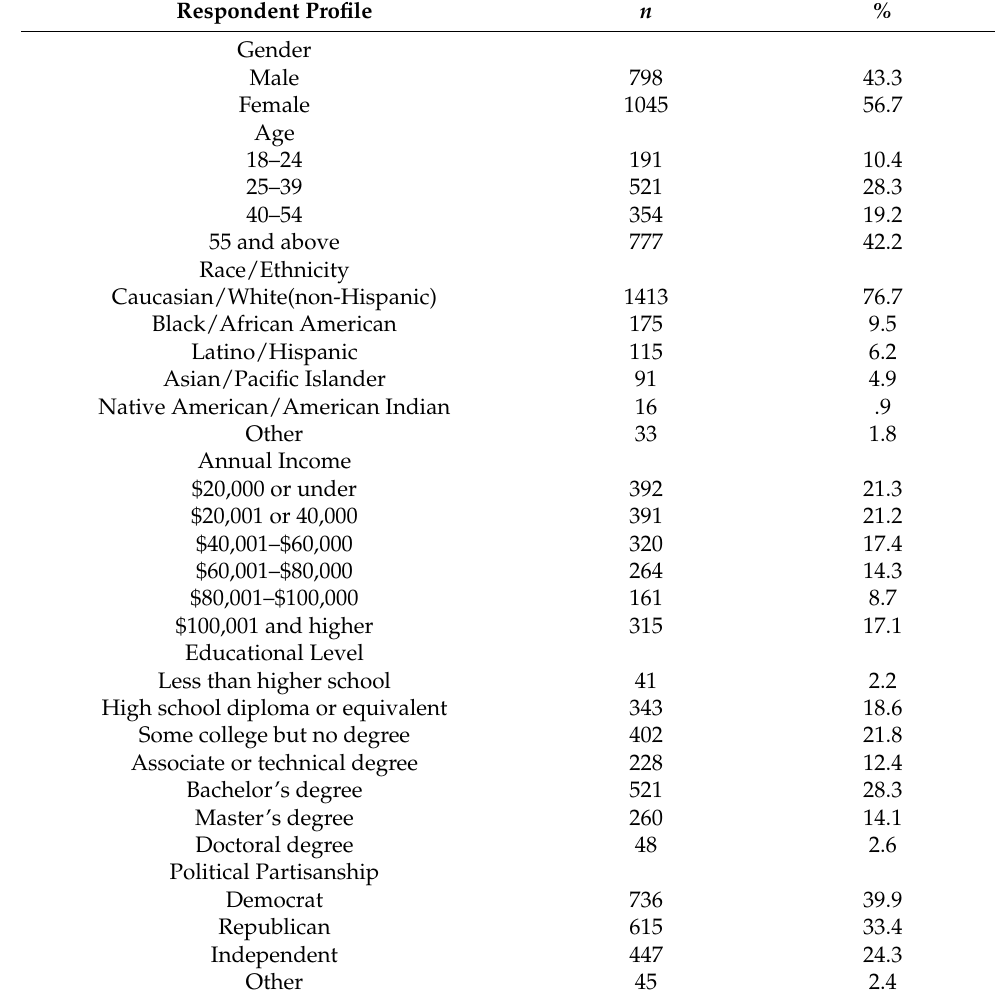
Table 1. Respondent profile for the study ( n =